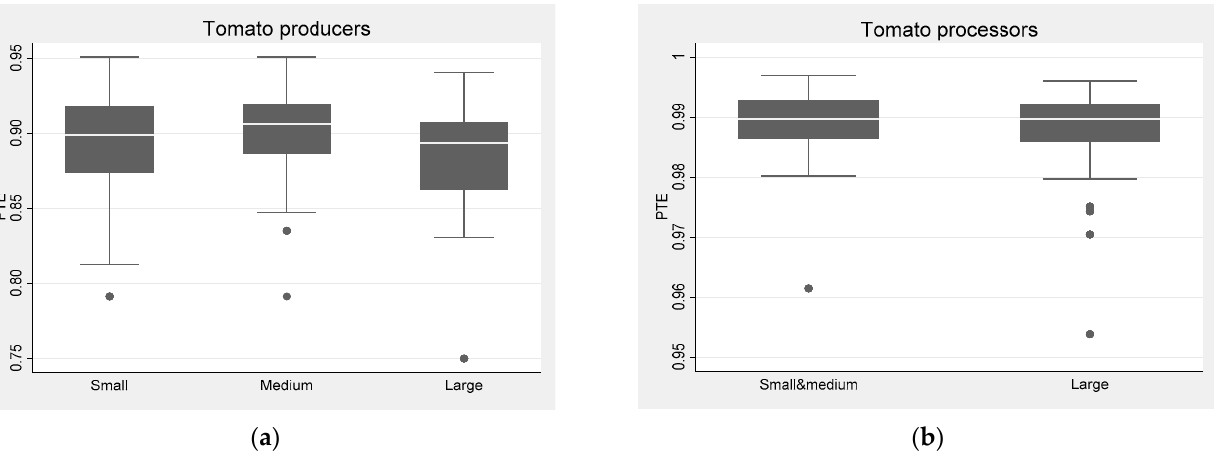
Figure 6. Distribution of transient technical efficiency; ( a ) tomato producers and ( b ) tomato processors. Source: authors’ calculations.